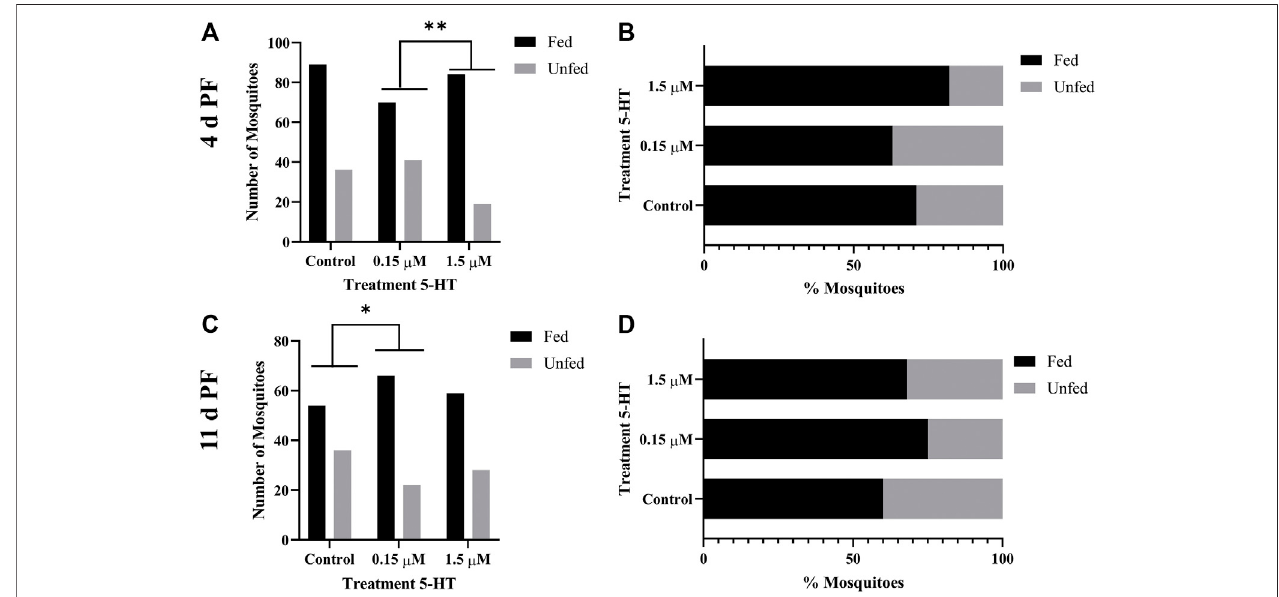
FIGURE 8 | Tendency of 5-HT primed A. stephensi infected with P. yoelii yoelii 17XNL to take a second bloodmeal at 4 days or 11 days post feeding (PF). (A) Numbers of fed and unfed infected mosquitoes at 4 d PF and (B) data from (A) shown as percentages of fed and unfed infected mosquitoes in each group. N = 6;